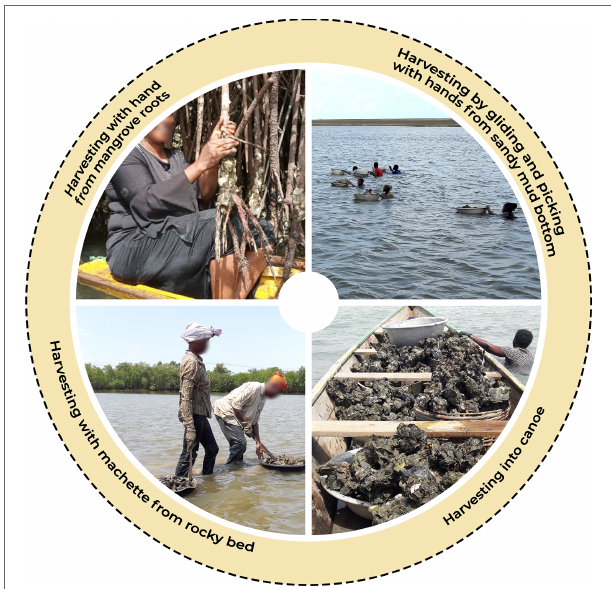
FIGURE 6 | Different modes of harvesting oysters by women. Some women harvest directly from mangrove roots with their hands or a hatchet, others harvest oysters from the bed of the estuary by wading through and picking with hands and placing them into pans and canoes, and in estuaries with hard/rocky beds, a cutlass is used to remove oysters. [Data source: All images captured by authors for this study.].